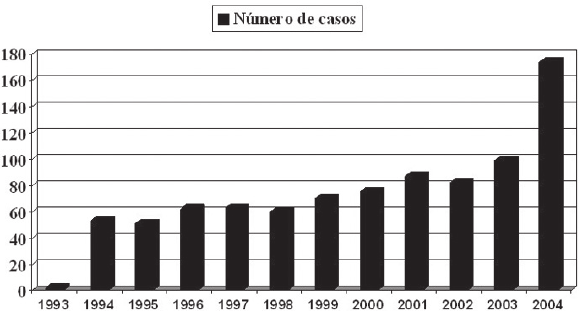
Fig. 2 – Evolução anual do número de operações realizadas no Caribbean Heart Care